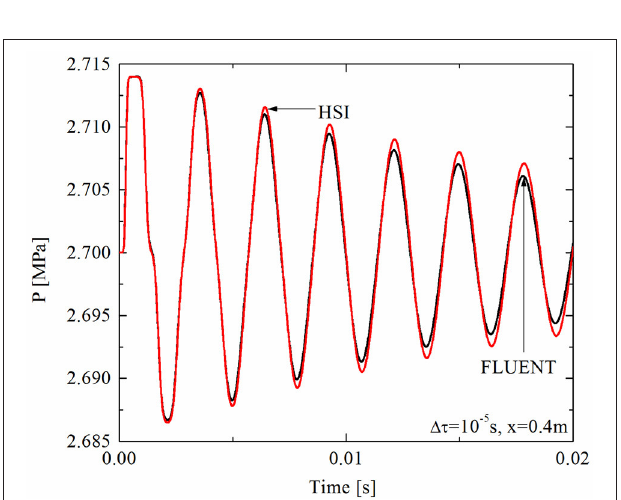
FIGURE 11 | Comparisons of the HSI method and FLUENT under inlet mass flow transient.